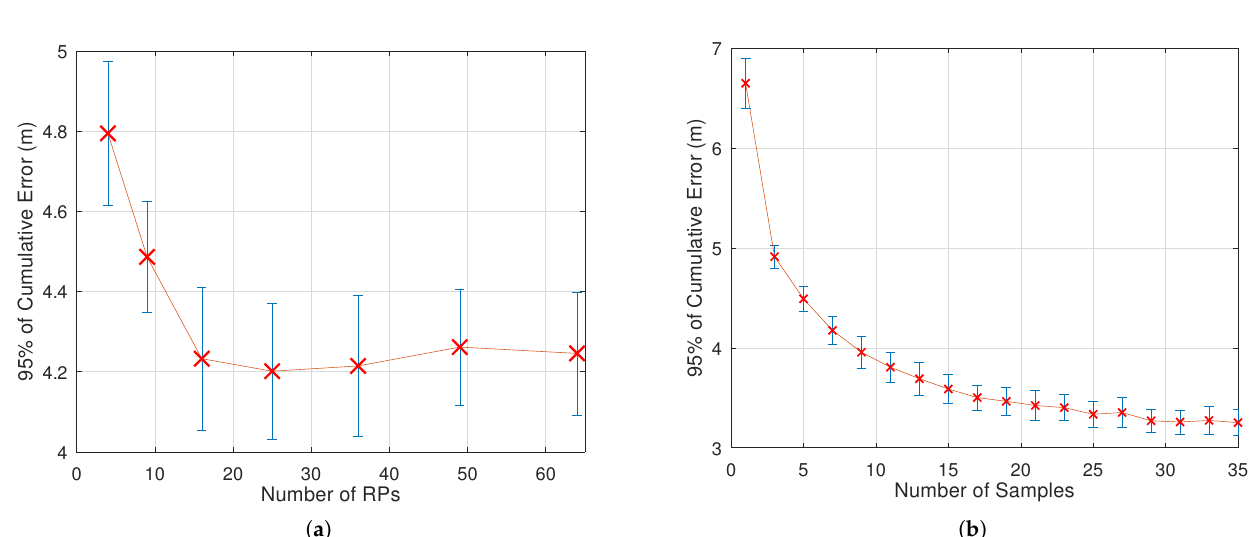
Figure 4. Variation of 95% cumulative error with ( a ) number of RPs and ( b ) number of samples. The “X” symbols indicate the average errors and the bars the mean standard